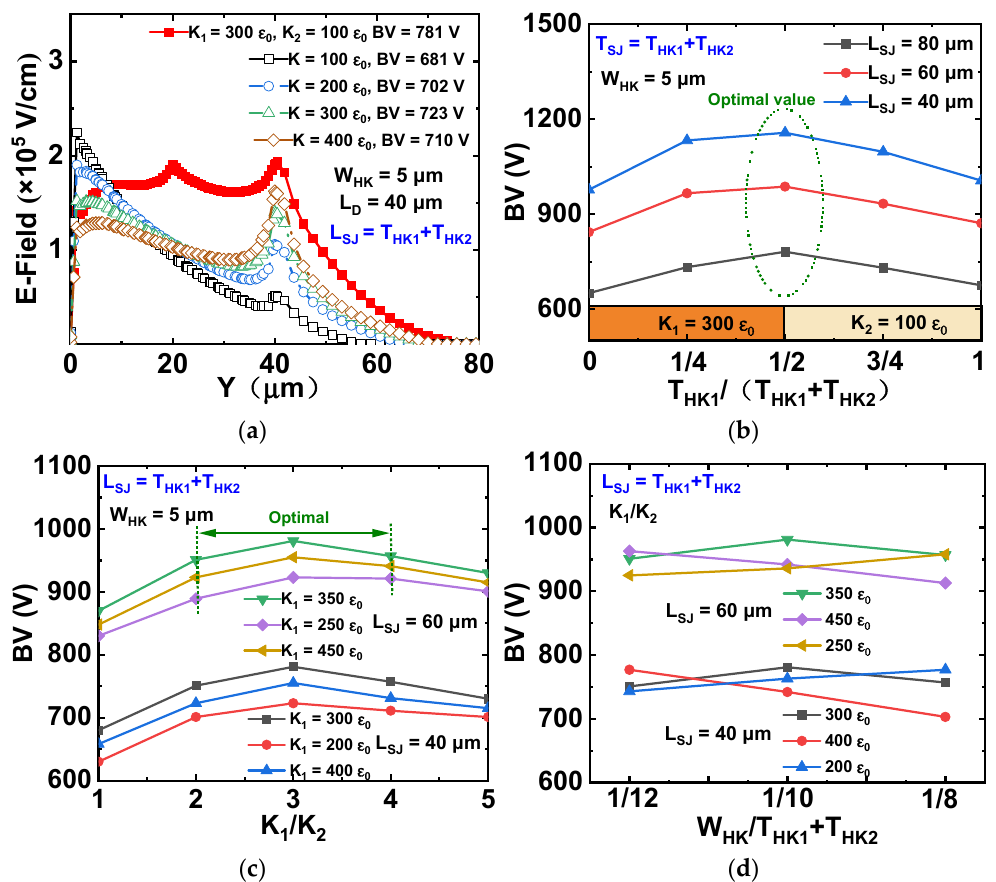
Figure 5. ( a ) Dependences of vertical E-field and BV on different K values, ( b ) dependences of BV on different ratios T HK1 to (T HK1 + T HK2 ) with three different L SJ (40 µ m, 60 µ m and 80 µ m), ( c ) dependences of BV on different ratios of K 1 to K 2 , ( d ) dependences of BV on different ratios of W HK to (T HK1 + T HK2 ) for VHK SJ-LDMOS.